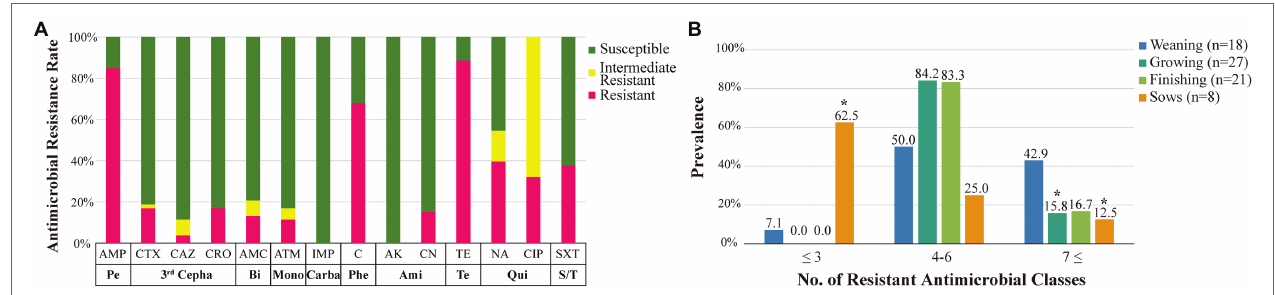
FIGURE 4 | Antimicrobial susceptibility of MCR1-EC strains and prevalence of resistant MCR1-EC. Antimicrobial susceptibility of MCR1-EC from swine farms (A) and prevalence of MCR1-EC isolates resistant to different numbers of antimicrobial classes by swine production stage (B) . MCR1-EC, Escherichia coli carrying the mobilized colistin resistance gene mcr-1.1 ; Pe, broad spectrum penicillin class; third Cepha, third-generation cephalosporin class; Bi, β -lactamase inhibitor class; Mono, monobactam class; Carba, carbapenem class; Phe, phenicol class; Ami, aminoglycoside class; Te, tetracycline class; Qui, quinolone class; S/T, sulfonamide/ trimethoprim class; AMP, ampicillin; CTX, cefotaxime; CAZ, ceftazidime; CRO, ceftriaxone; AMC, amoxicillin/clavulanate; ATM, aztreonam; IMP, imipenem; C, chloramphenicol; AK, amikacin; CN, gentamycin; TE, tetracycline; NA, nalidixic acid; CIP, ciprofloxacin; and SXT, sulfamethoxazole/trimethoprim. * p < 0.05, significantly different prevalence relative to that of weaning piglets, calculated via